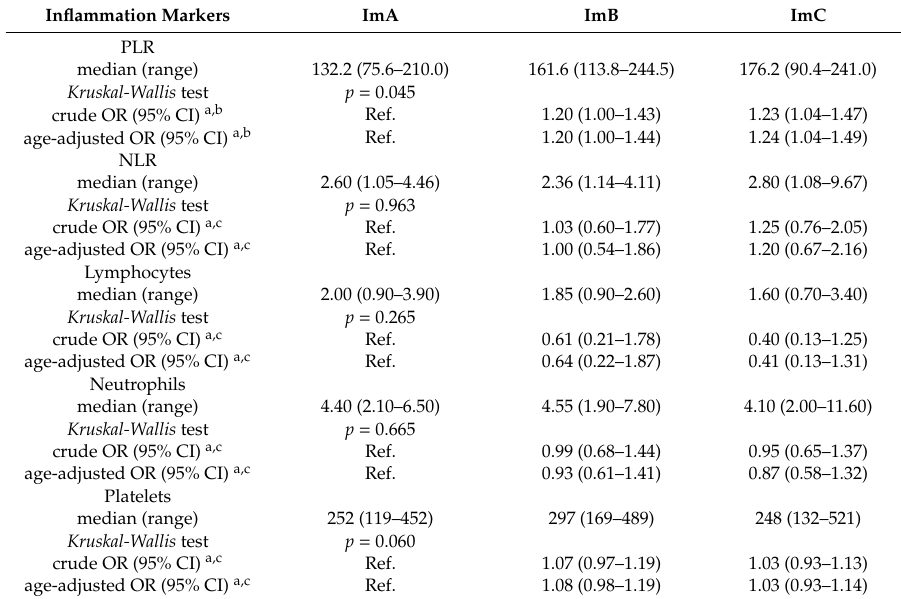
Table 1. Association between markers of systemic inflammation and